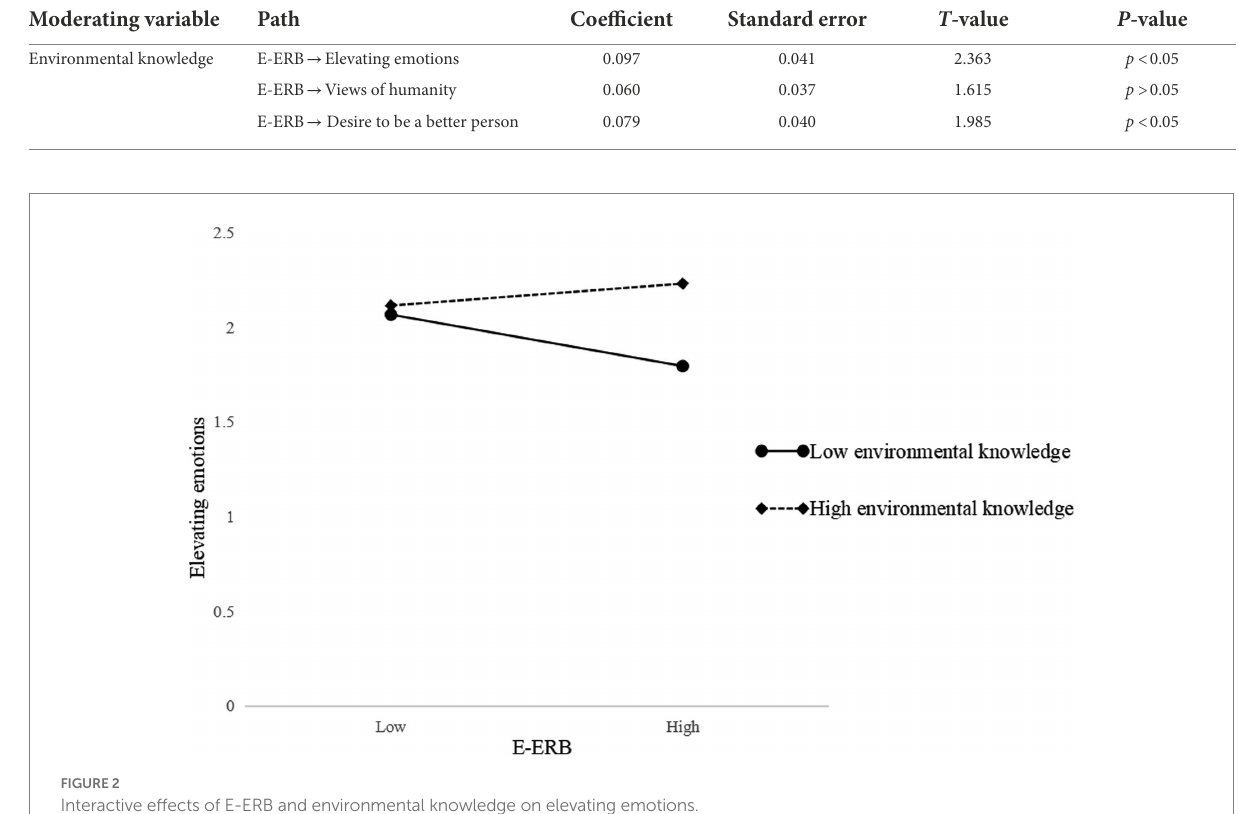
TABLE 5 Results of moderating effect.